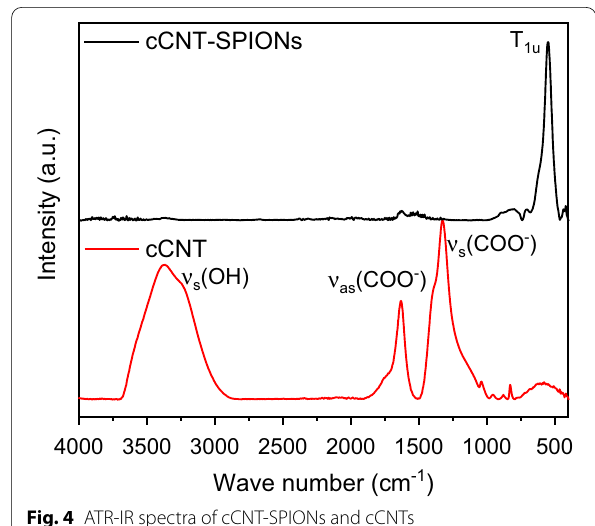
Fig. 4 ATR‑IR spectra of cCNT‑SPIONs and cCNTs